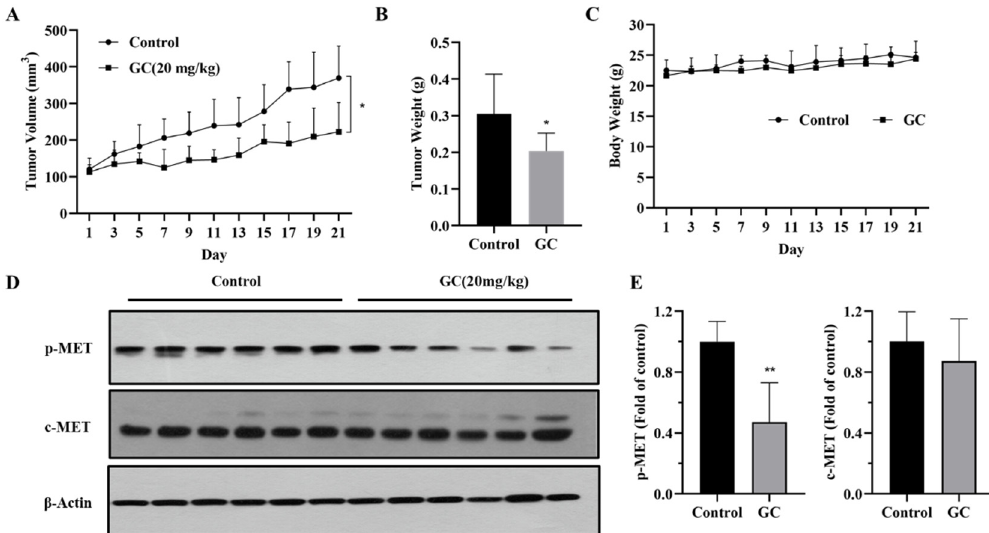
Figure 2. Glycyrol inhibits tumor growth in HCC827GR xenograft model. ( A ) Inhibitory effect of glycyrol on tumor growth. ( B ) Reduction of the final tumor weight. ( C ) Bodyweight kinetics of mice. ( D , E ) Phospho-MET in tumor samples (each band represents one tumor sample). * p < 0.05, ** p < 0.01.